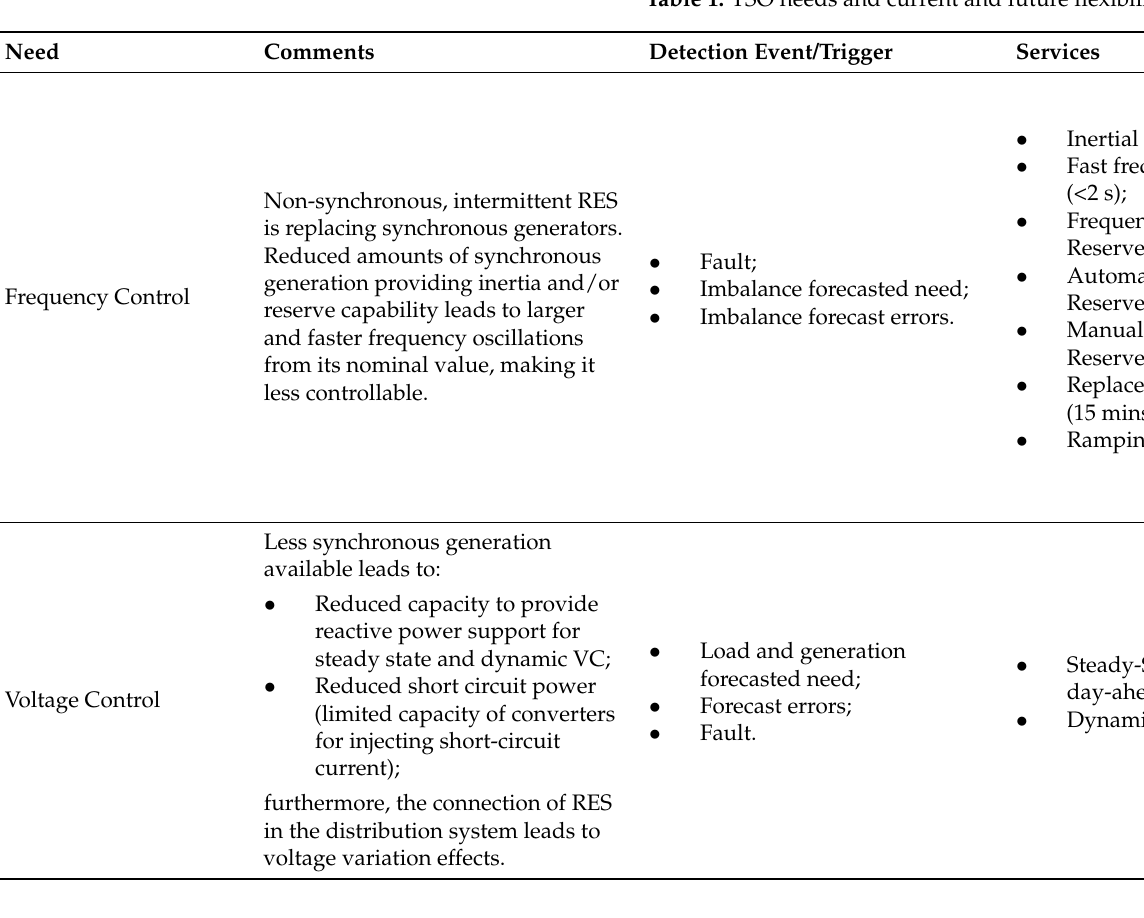
Table 1. TSO needs and current and future flexibility